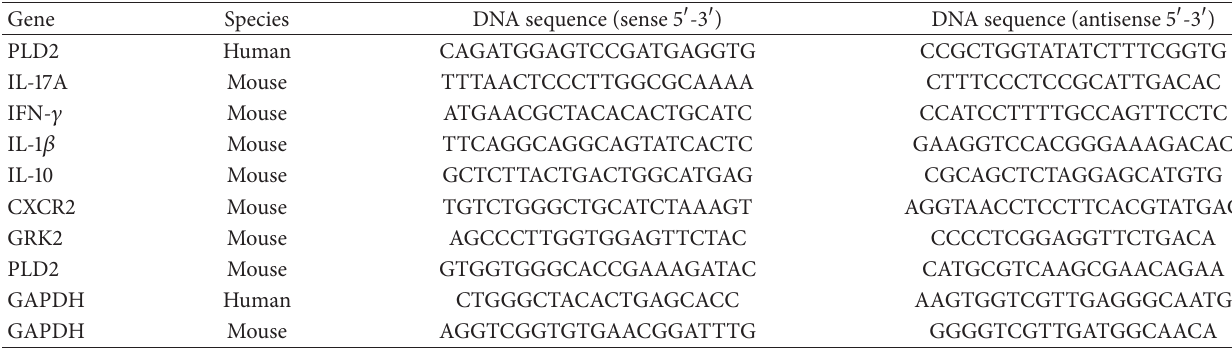
Table 1: The primers using in qRT-PCR